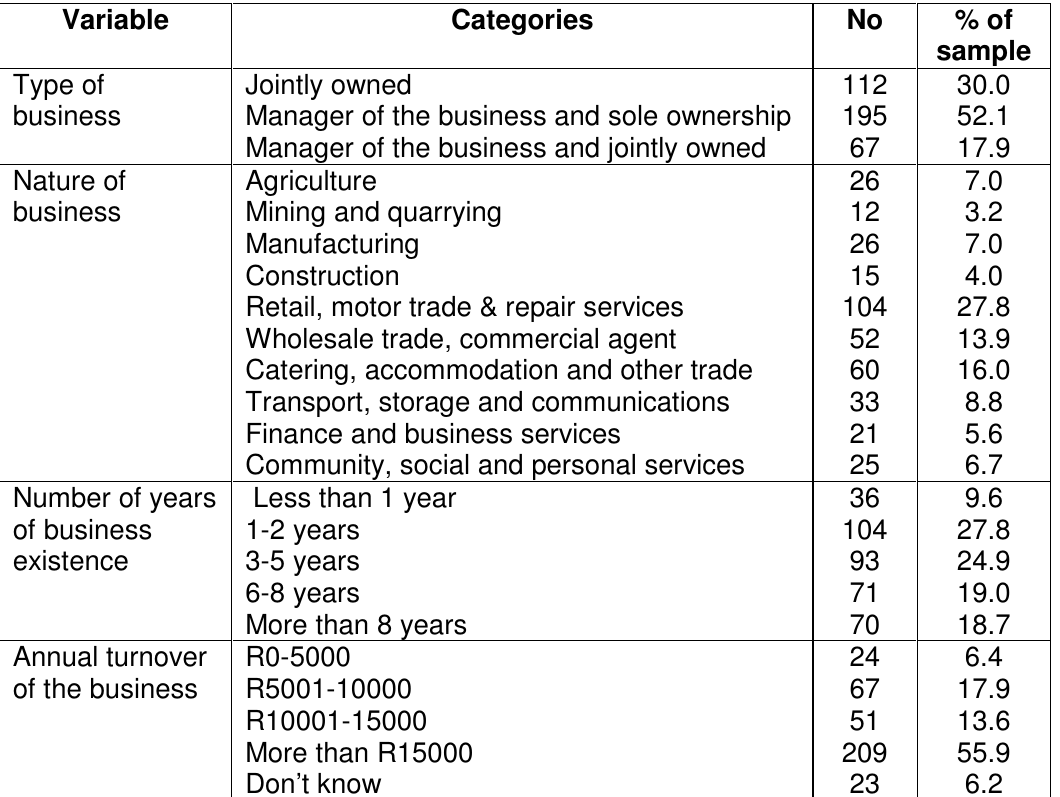
Table 3: Profile of participating SMMEs (n = 374)